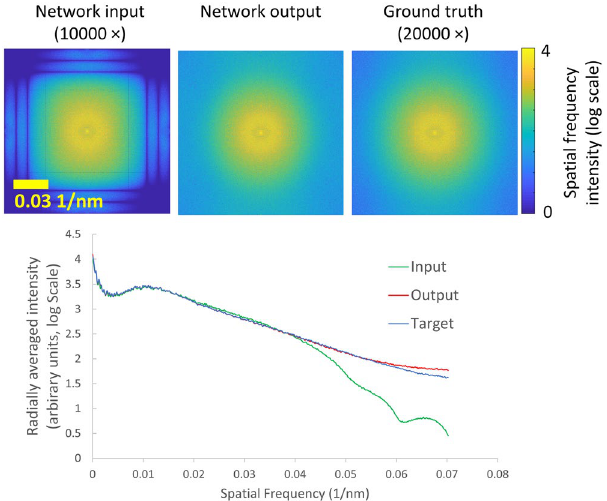
Figure 4. Top: spatial frequency distributions of the average of five up-sampled input, output, and ground truth images are compared. Bottom: radially-averaged plot of the above distributions. Analysis was performed on the uncropped versions of the SEM images shown in Fig. 2 as well as three additional